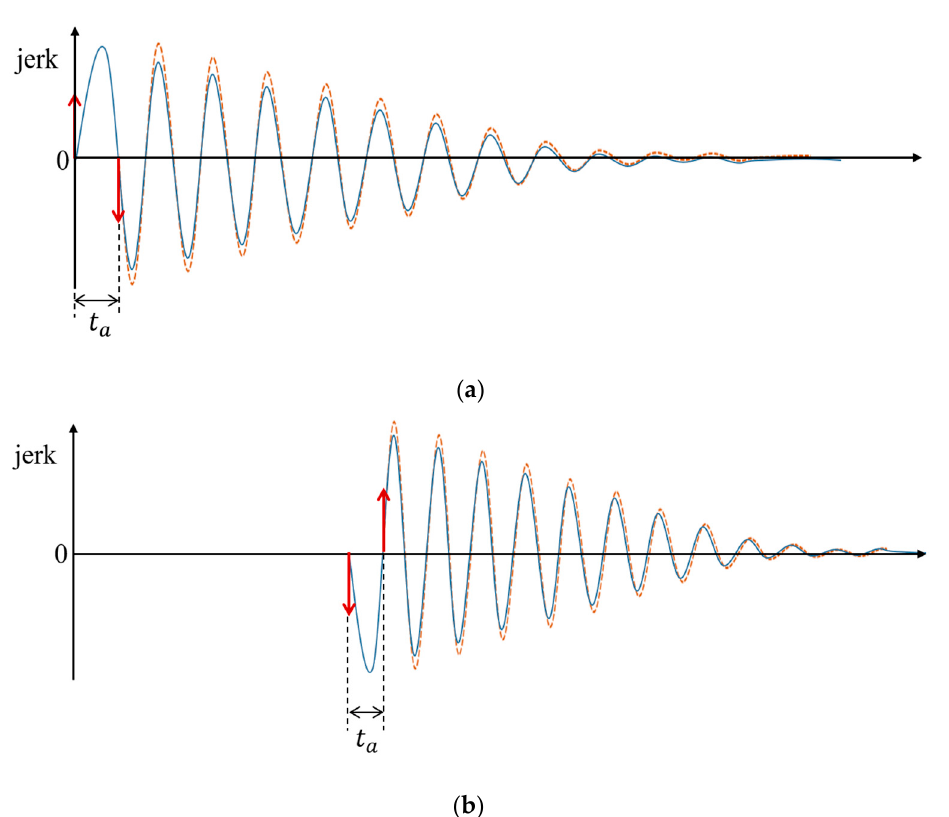
Figure 6. The case where residual vibrations caused by two jerks are amplified: ( a ) in acceleration phase; ( b ) in deceleration phase.